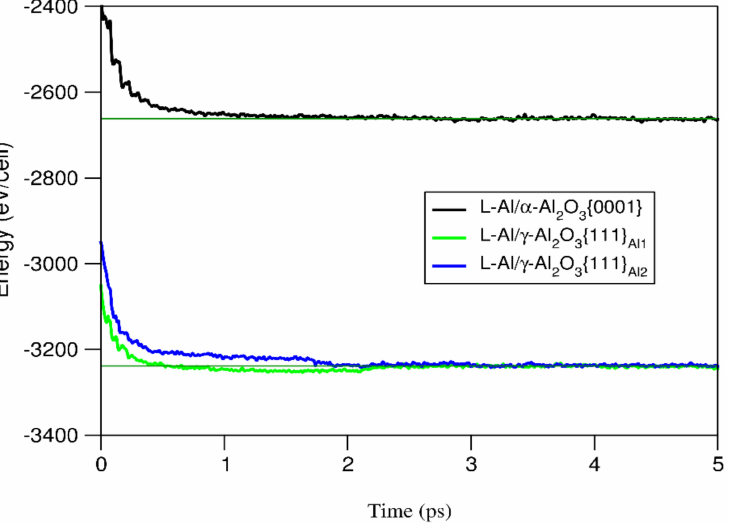
Figure 2. The two Al(l)/ γ -Al 2 O 3 {1 1 1} interfaces have similar energies at equilibrium at 1000 K. Dependences of total valence-electrons energies of the Al(l)/Al 2 O 3 systems on simulation time [49,62]. The straight dark-green lines represent the energies at equilibrium.